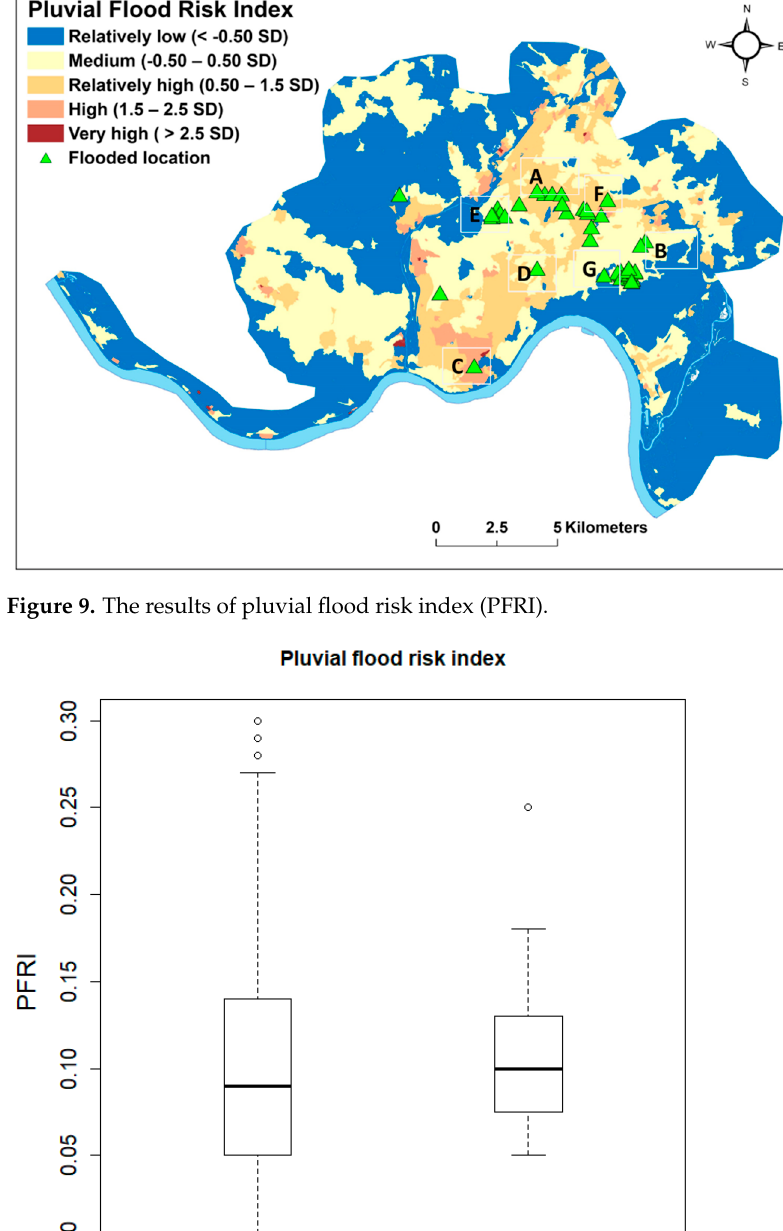
Figure 10. Boxplot of the PFRI values for all the catchments and the flooded catchments.